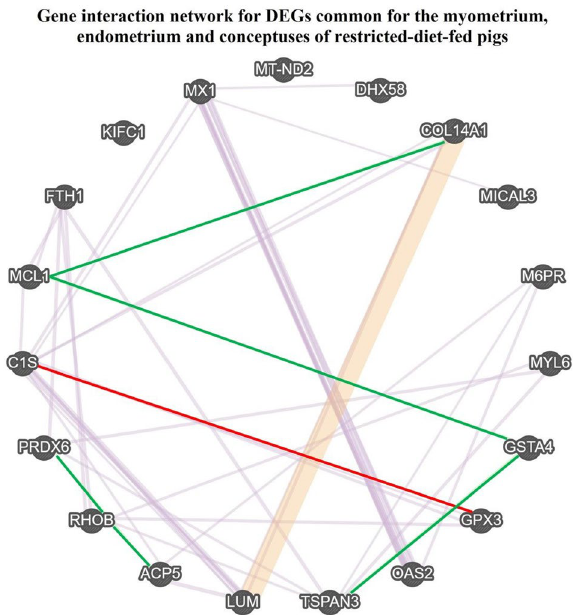
Figure 3. The gene interaction networks among common genes in the myometrium, endometrium, and embryos of pigs during the peri-implantation period that were differentially expressed (DEGs) in response to peri-conceptional undernutrition. Thread contacting visualized genes indicate specific gene interactions: red: co-localization, violet: co-expression, pink: physical interactions, green: genetic interactions. Figure generated in GeneMania Prediction server (https:// genem ania. org/) with